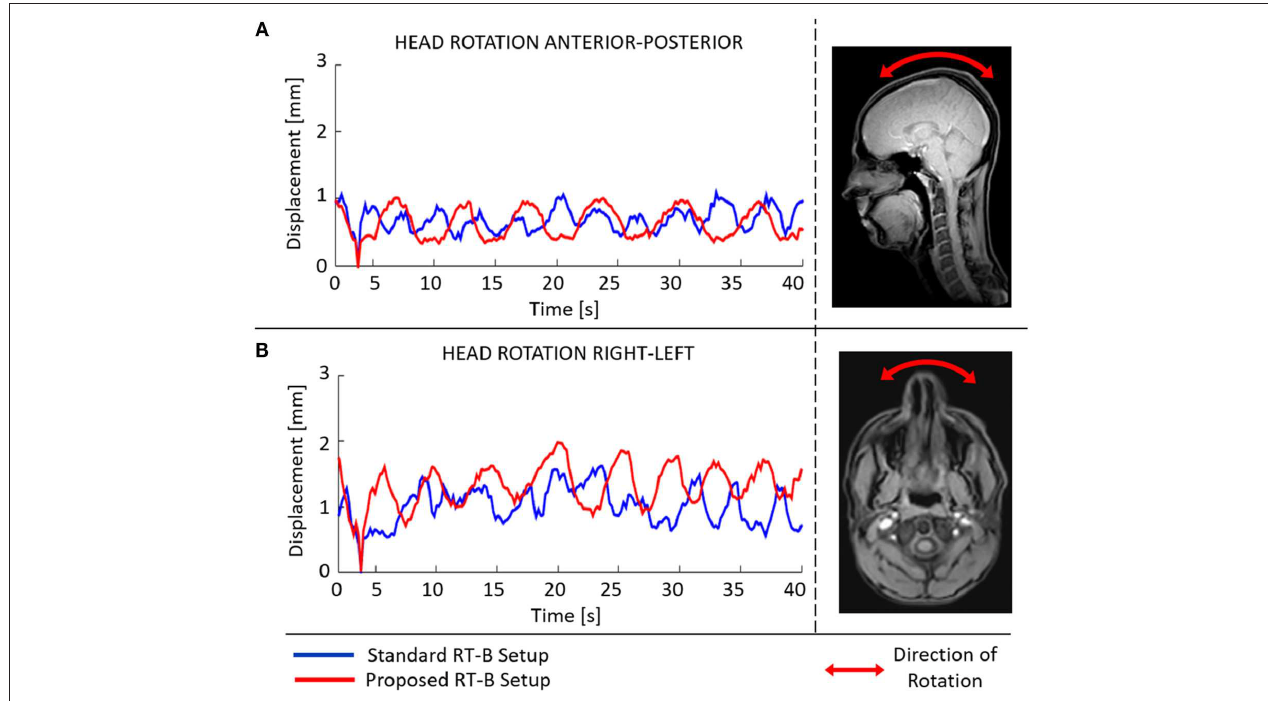
FIGURE 4 | Mean absolute displacement [anterior-posterior (A) , right-left (B) ] inside the radiotherapy immobilization mask as determined from cine-MRI images acquired using the standard (blue) and the proposed (red) RT-B.